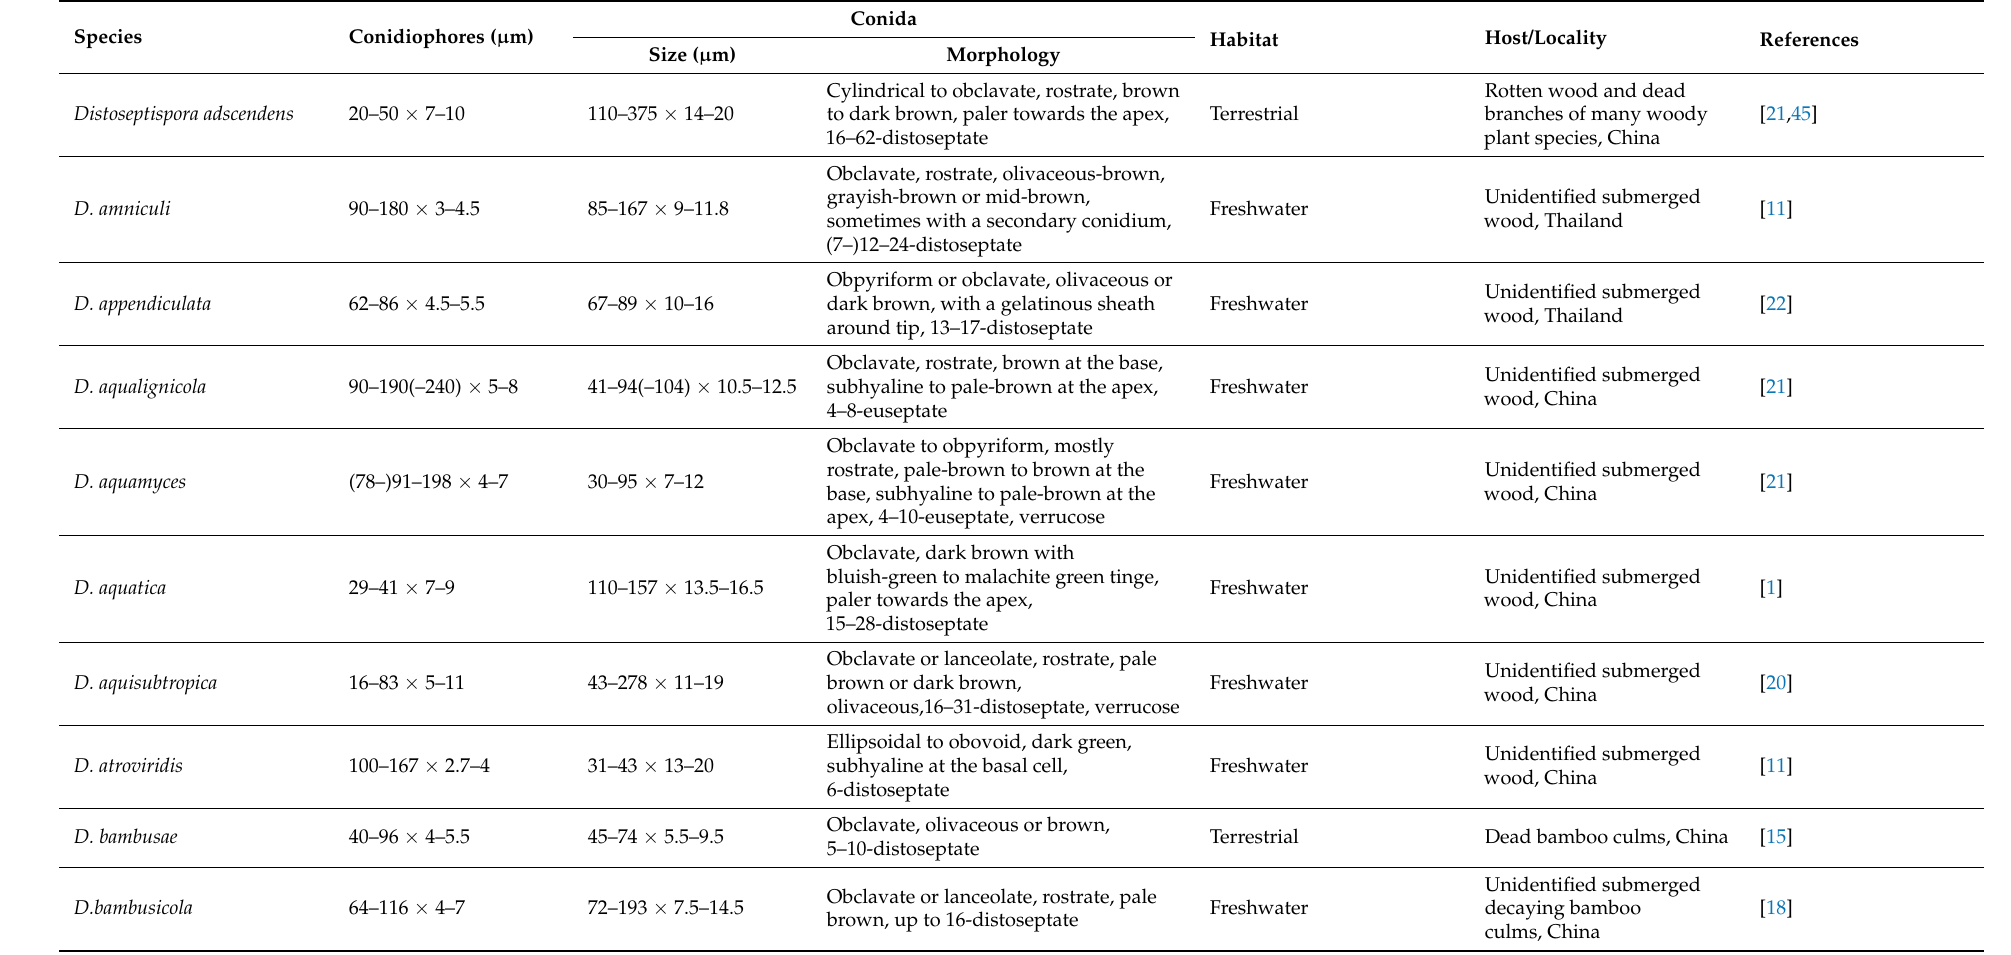
Table 2. Synopsis of morphological characteristics, habitat, host, and locality compared across Distoseptispora anamorph